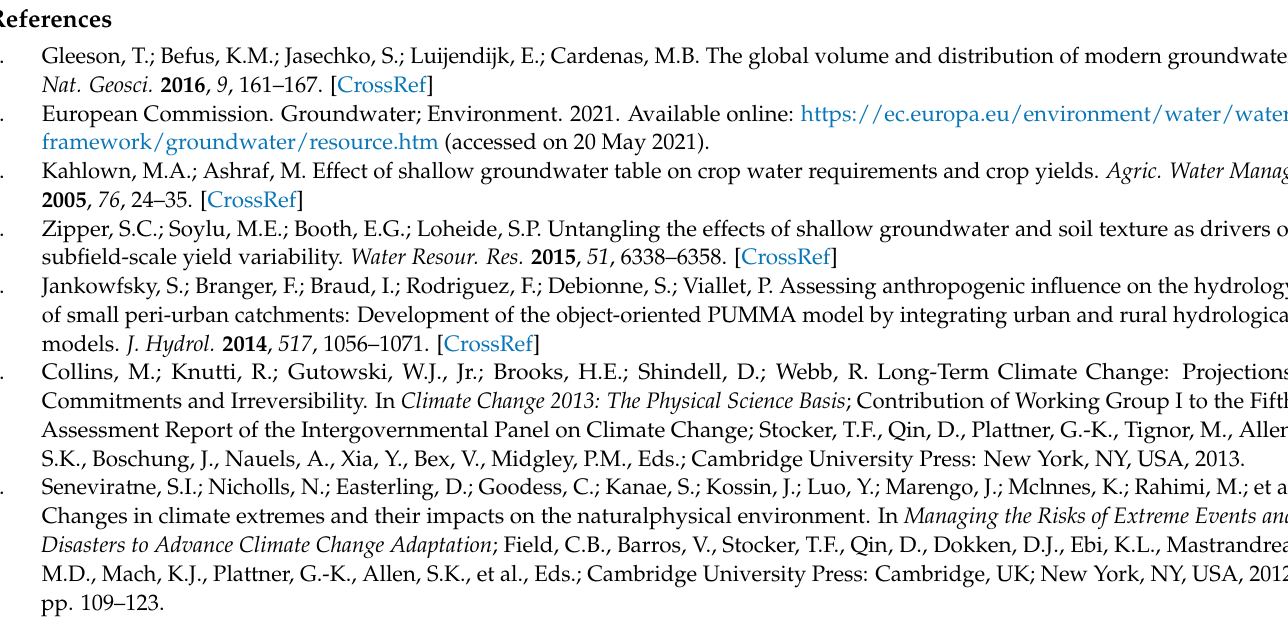
Figure A3. Comparison with one of the SSPs in a zoomed-in area where there are noticeable change in the water table